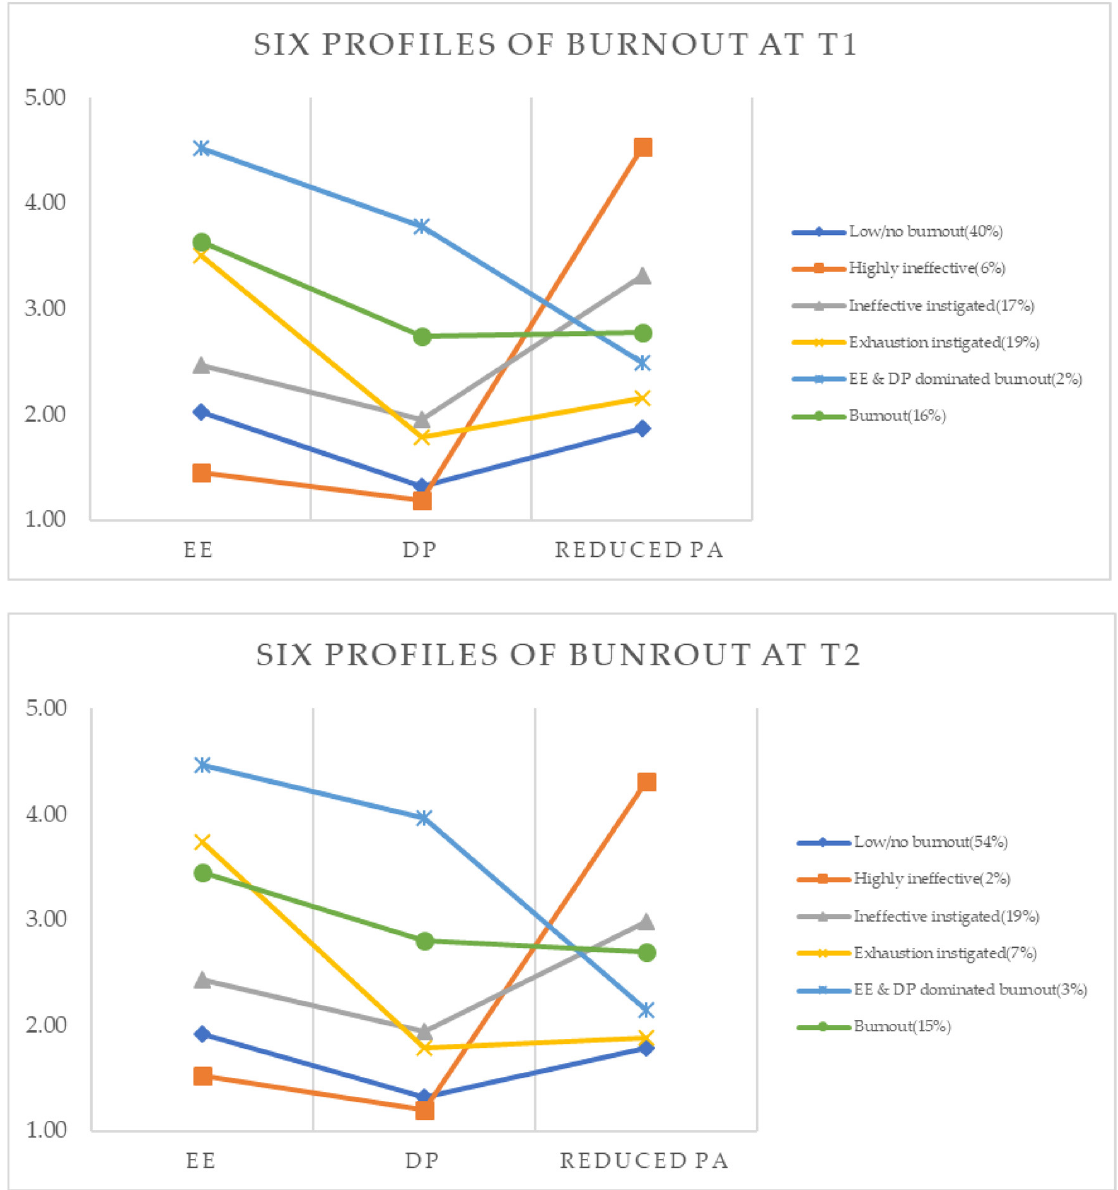
Figure 1. Six latent profiles of burnout at T1 and T2.